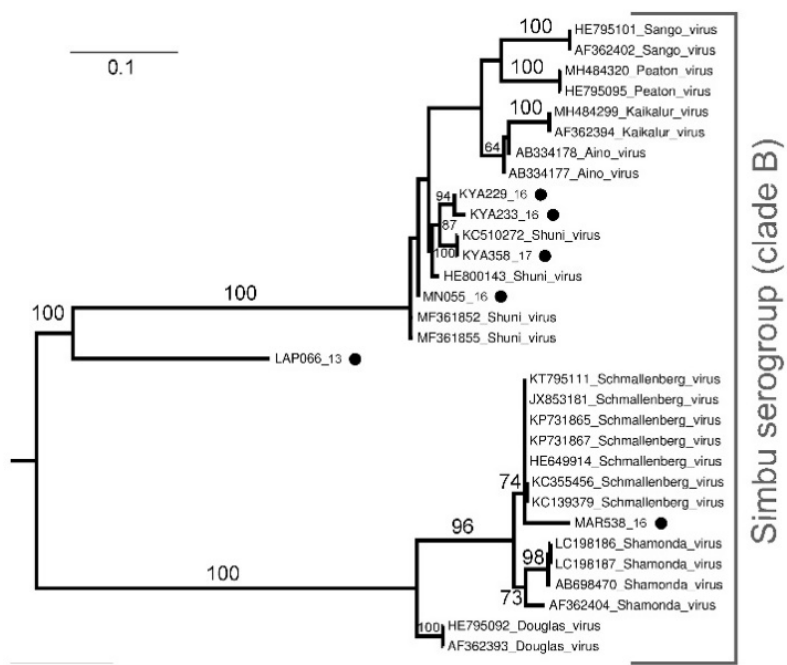
Figure 2. Orthobunyavirus phylogram of the partial (nucleotides = 503, 32 taxa) S segment. Bootstrap support (<60 omitted) calculated using autoMRE function invoked in RAxML (GTR + G model). Phylogram rooted at midpoint. Filled black circles indicate new sequences for viruses detected in this study.